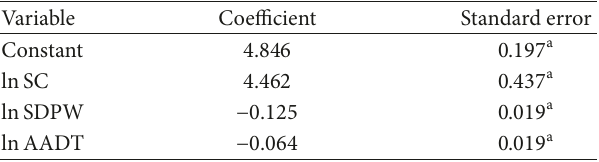
Table 2: Results of the stochastic frontier